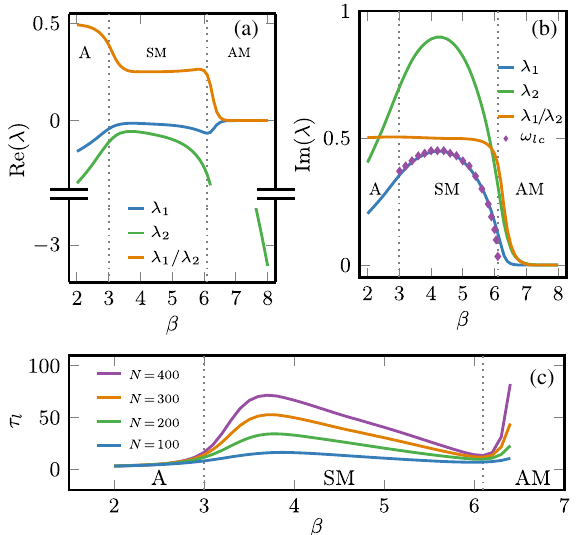
FIG. 5. The real part (a) and the imaginary part (b), as well as the ratio, of the two most dominant eigenvalues with a distinct real part, λ 1 and λ 2 , with a positive imaginary part are depicted as a function of β . In addition, the LC frequency ω numerically extracted from the asymptotic ( t → ∞ ) MF dynam- ics is compared to the imaginary part of the most dominant eigenvalue. All eigenvalues correspond to a generator W for a system of size N ¼ 300 . (c) shows the lifetime of the metastable state τ as a function of β for different system sizes. The labels of l the different phases, that is, the asynchronous phase (A), the synchronous metastable phase (SM), and the asynchronous metastable phase (AM), are in correspondence with the labels of the different phases in the MF limit introduced in Sec.